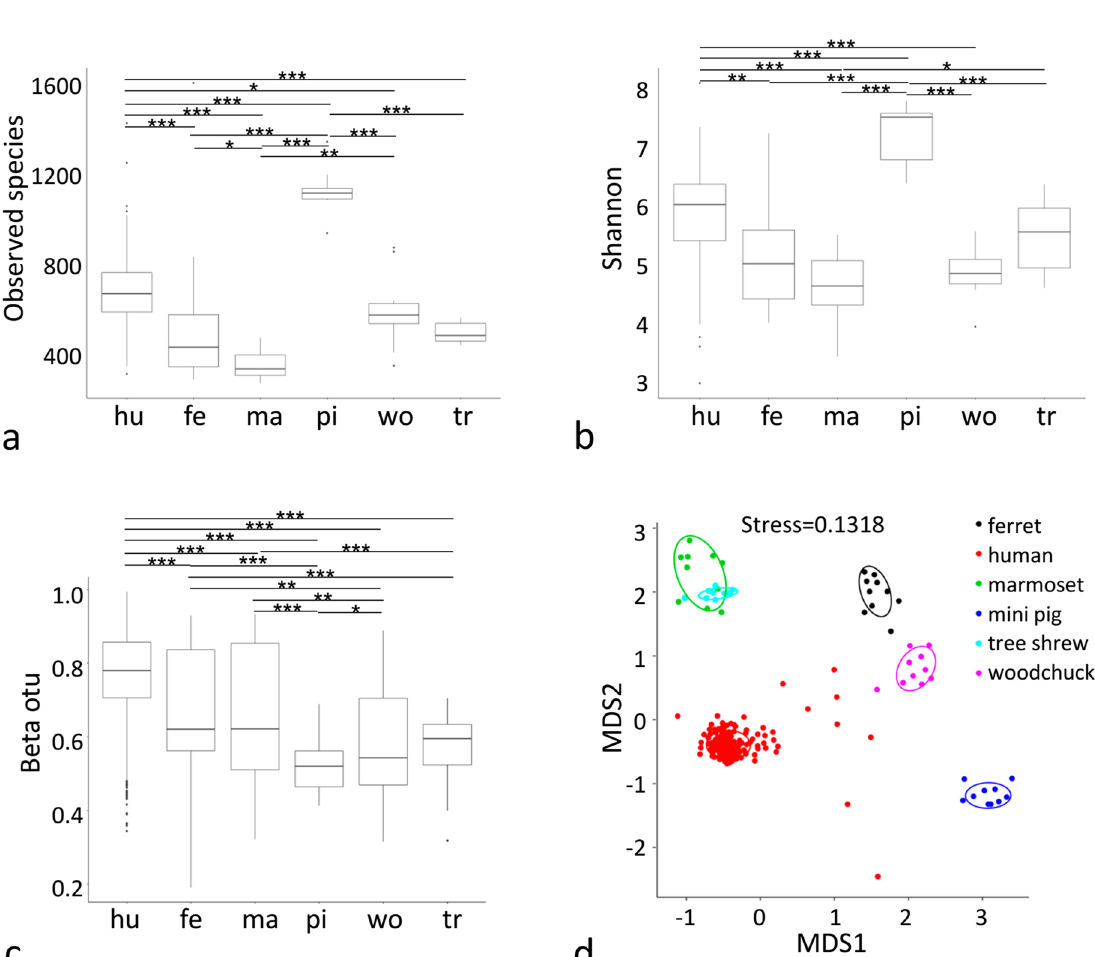
Figure 1. Statistical differences in the gut microbiota from human and five animal species. α-diversity estimates of the microbiota of human and five animal species based on OTU counts are shown as the numbers of observed bacterial species (a) and Shannon index (b) . β-Diversity is shown as beta OTU (c) . The Wilcox tests between groups are given. Significant differences areindicated with one asterisk ( *, Wilcox p-value < 0.05), two asterisks ( **, Wilcox p-value < 0.01) or three asterisks ( ***, Wilcox p-value < 0.001). Multi-dimensional scaling analysis result is shown in Fig.